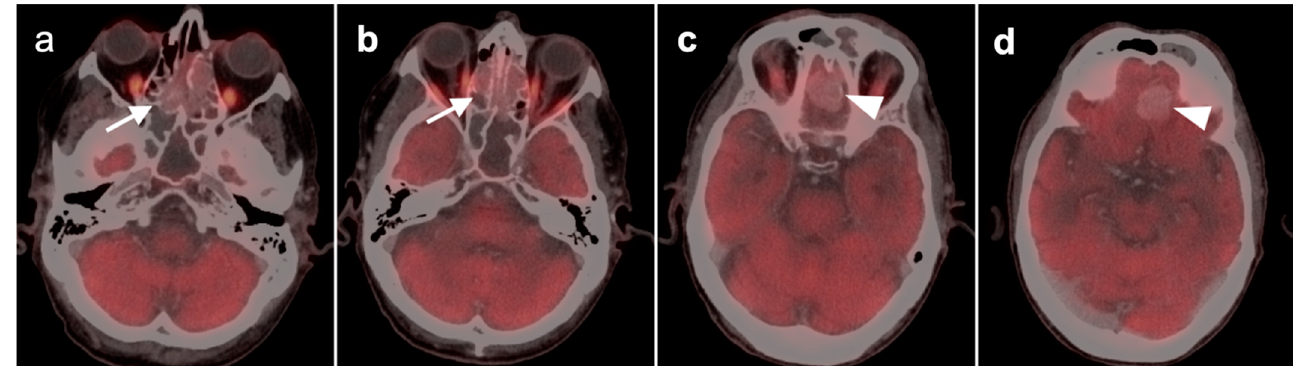
Figure 23. Esthesioneuroblastoma of the ethmoid sinus. ( a, b) Mildly hypermetabolic tumor fills the ethmoid sinuses on axial FDG PET ‐ CT images (white arrows); ( c , d ) The tumor extends through the cribriform plate into the anterior cranial fossa/brain (white arrowheads). Without contrast CT, the intracranial extension would be difficult to appreciate on FDG PET.